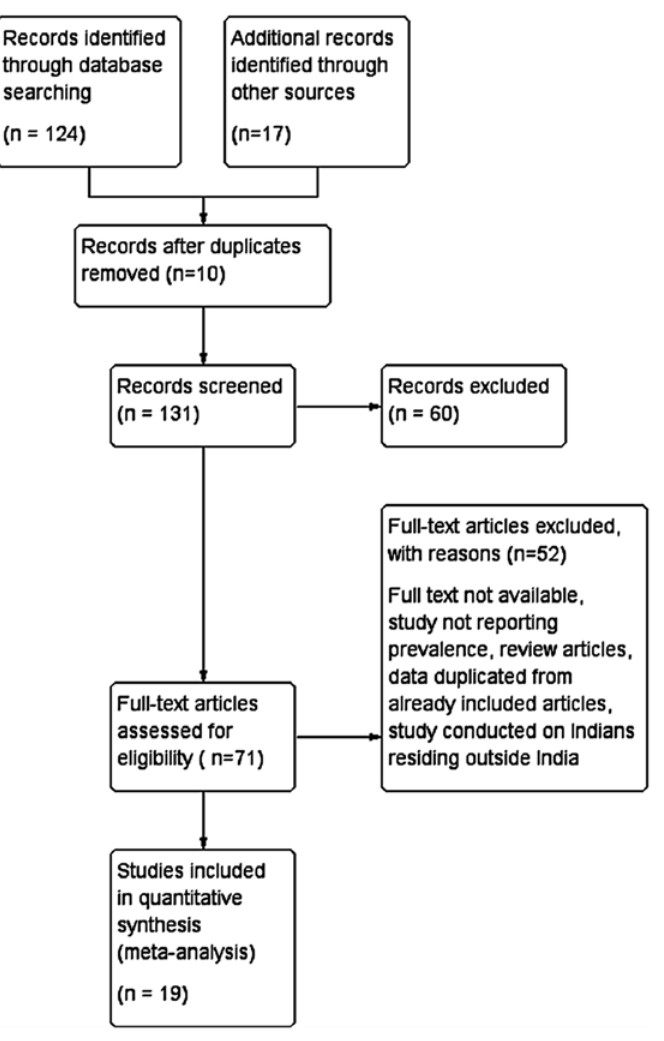
Fig 1. Literature search and selection of studies (PRISMA Flow